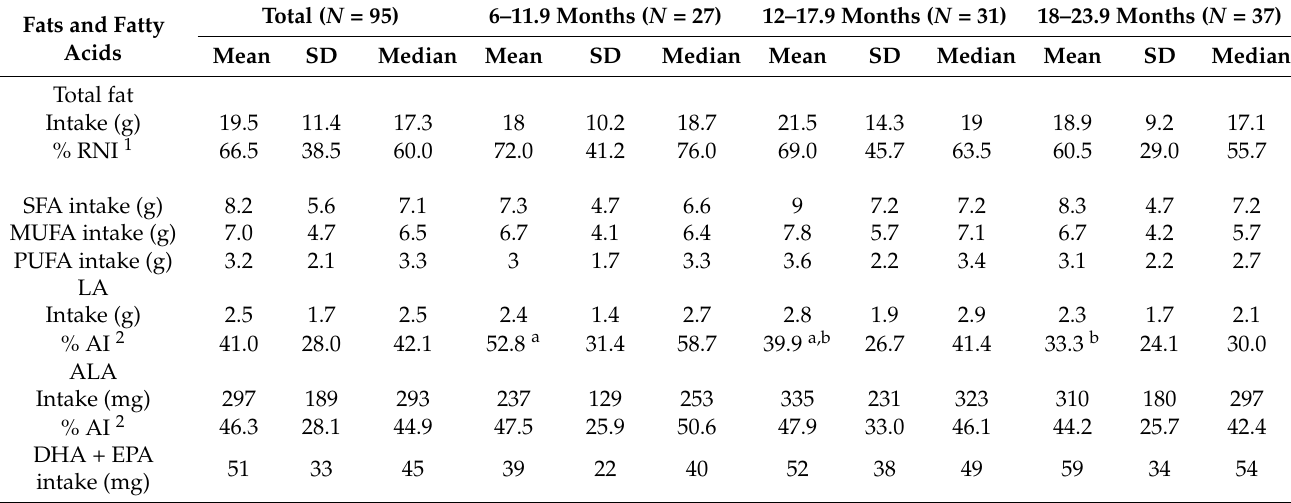
Table 7. Intake of fats and fatty acids from milk-based formulas per day (mean ± SD and median) according to age group ( N =